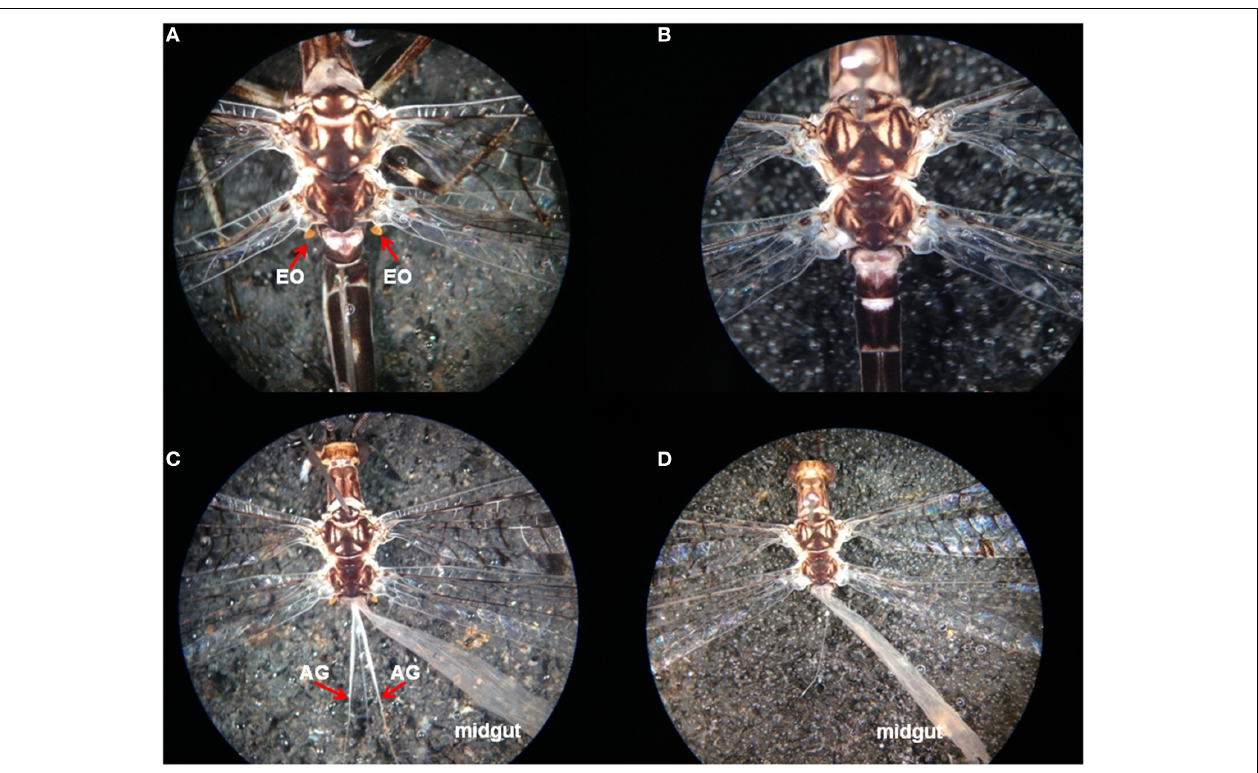
FIGURE 4 | (A) Male-specific Eltringham’s organs (EOs; red arrows) of Dendroleon speciosus ; (B) Shows that the EOs are missing from D. speciosus females; (C) Shows the male-specific abdominal glands (AGs;